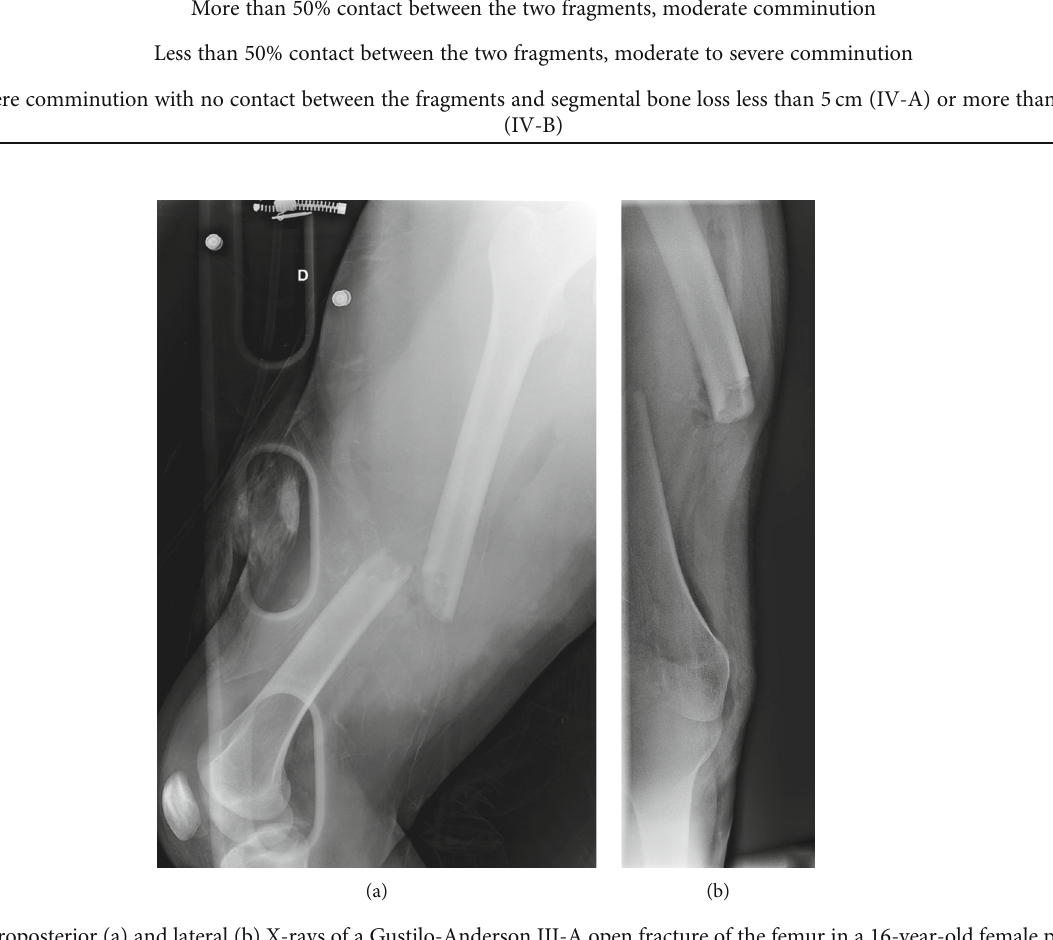
Figure 1: Anteroposterior (a) and lateral (b) X-rays of a Gustilo-Anderson III-A open fracture of the femur in a 16-year-old female